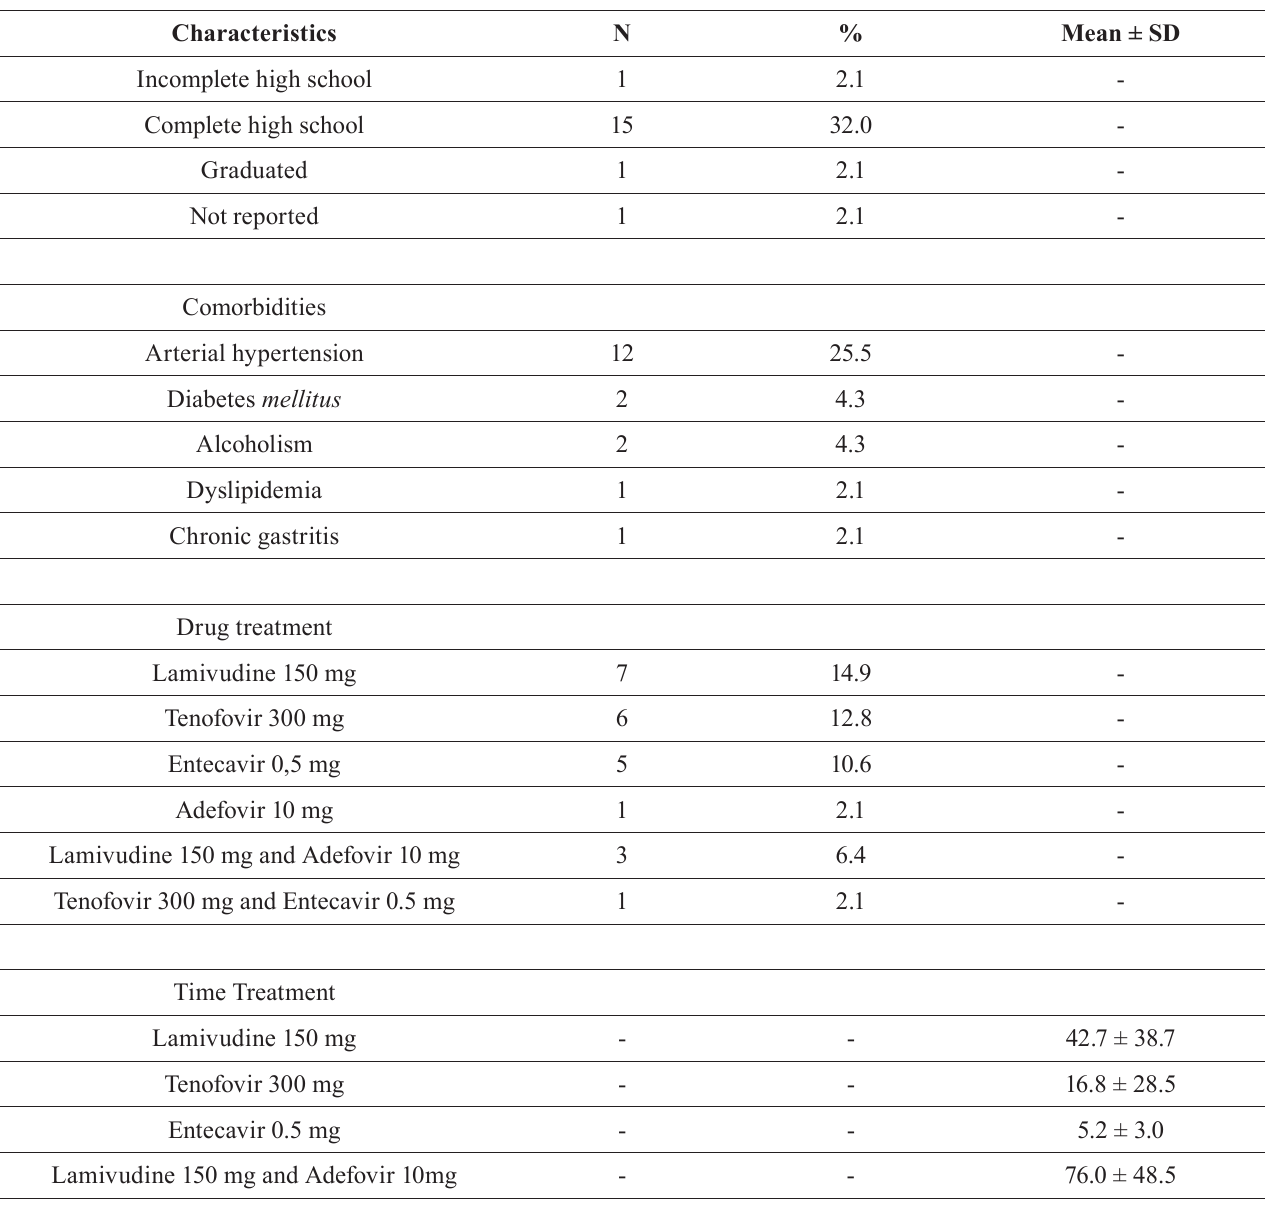
TABLE I - S ociodemographic characteristics of participants in the HBQOL validation in the city of Curitiba –